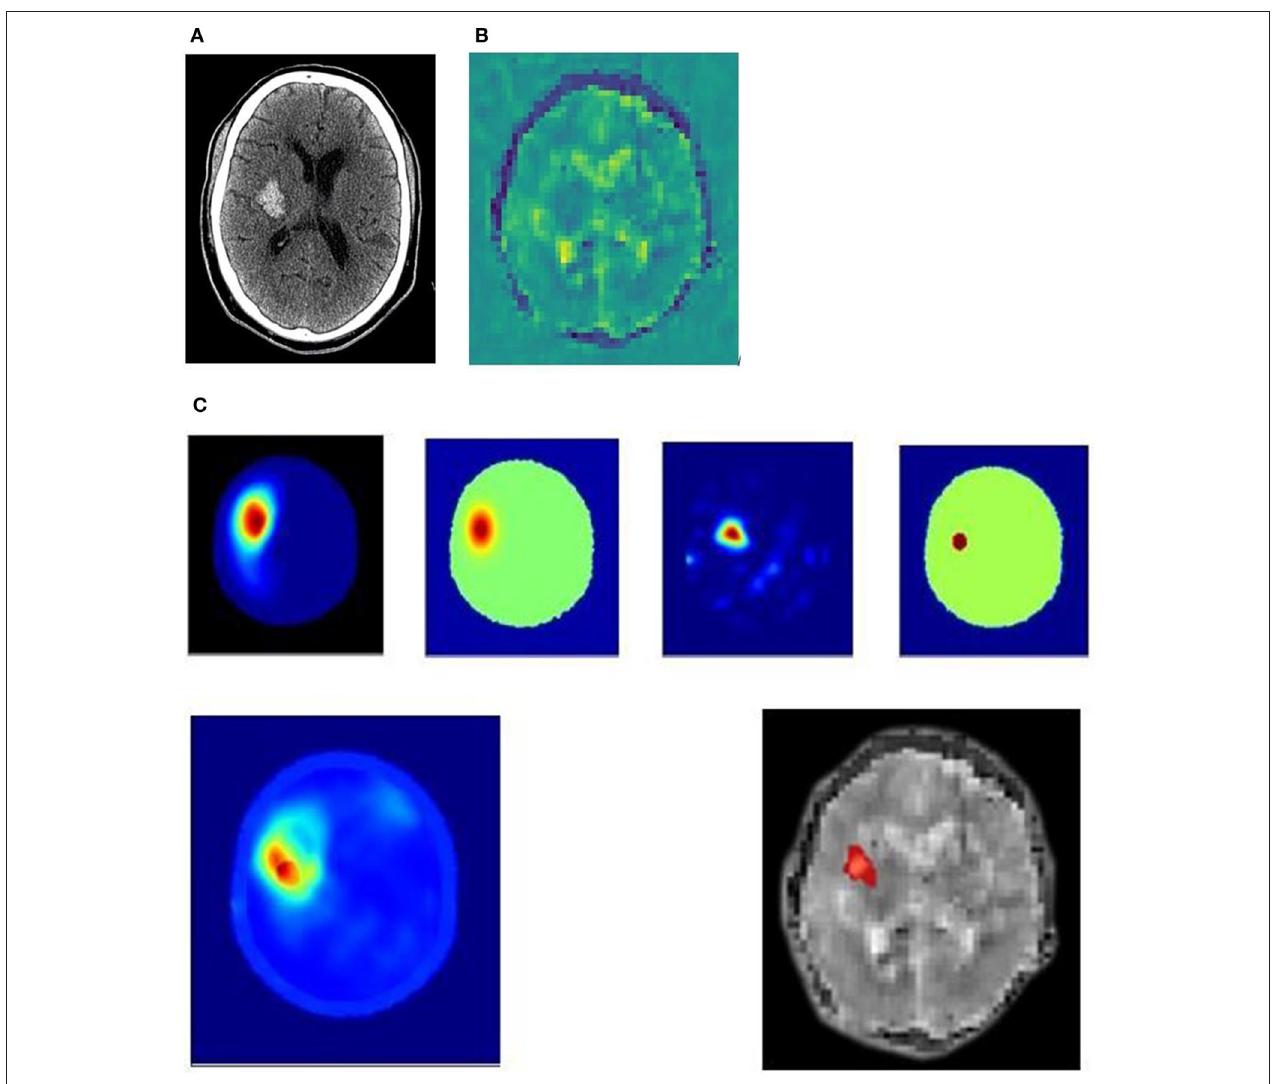
FIGURE 4 | (A–C) 51yo patient with a hemorrhagic stroke, right basal ganglia. (A) 51yo patient with a hemorrhagic stroke, right basal ganglia. Non-contrast CT performed 2 hrs after onset of left paresis and facial droop, showing acute hemorrhage. (B) 51yo patient with a hemorrhagic stroke, right basal ganglia. Dielectric permittivity map from an electromagnetic scan performed 7h after symptom onset. (C) 51yo patient with a hemorrhagic stroke, right basal ganglia. Examples of processing algorithm using radar-based frequency domain and time domain signal analysis, signal asymmetry, tomography and direct mapping. The algorithm outputs are fused into a representative image for localization. An artificial intelligence algorithm classifies haemorrhagic stroke with a red color code, while ischaemic stroke is color-coded as blue, and this is overlaid on a greyscale permittivity